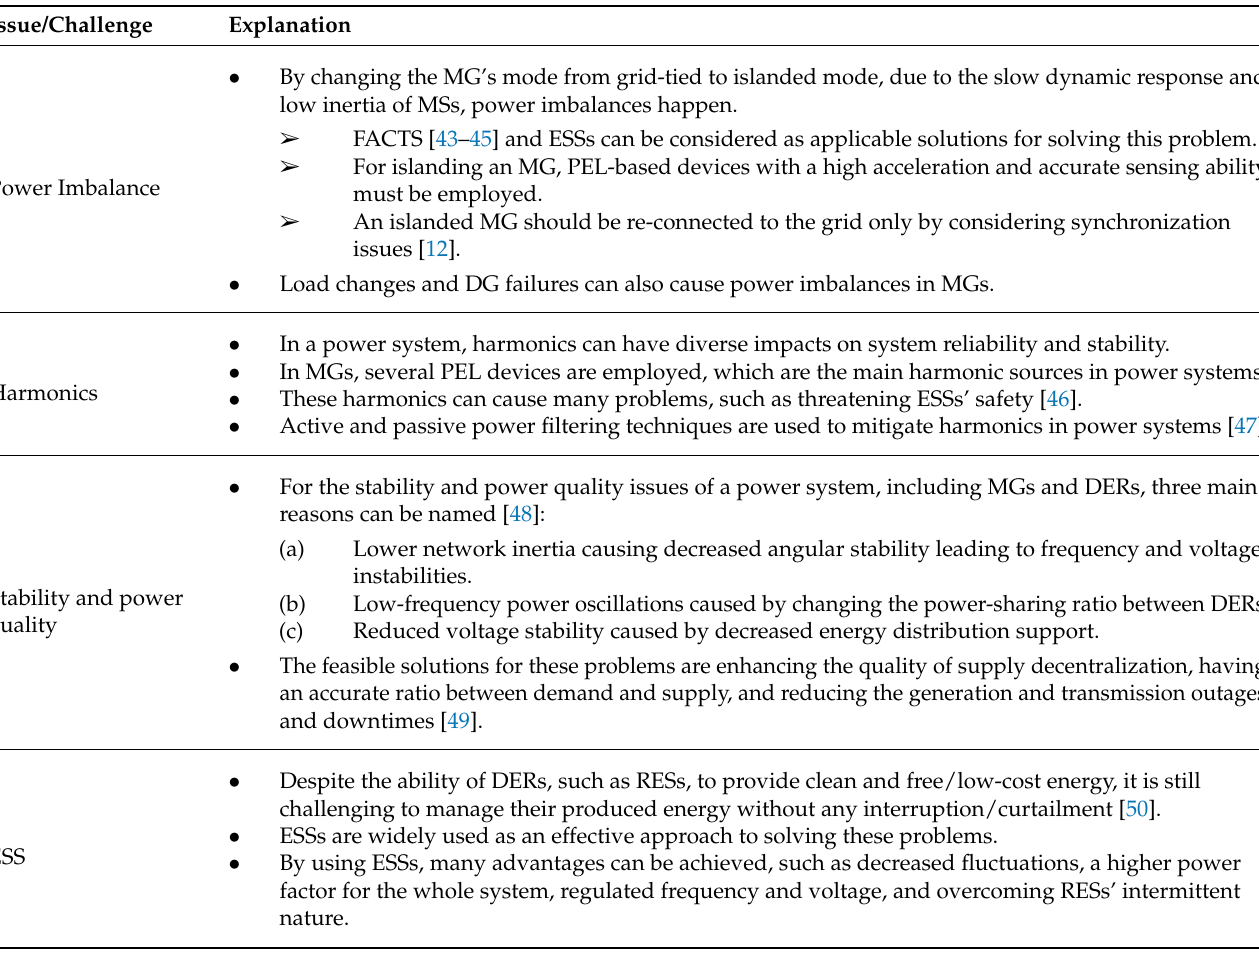
Table 6. Main technical and economic issues and challenges of